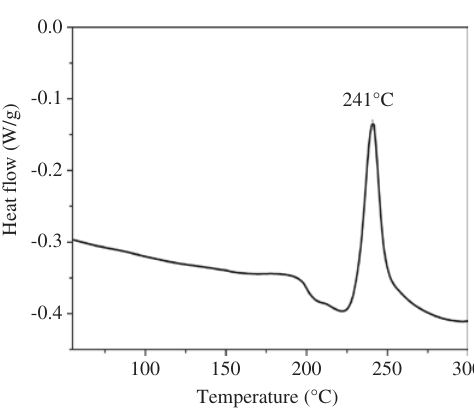
Figure 10: TGA thermograms of PAIc I, PAIc II and PAIc I2h.